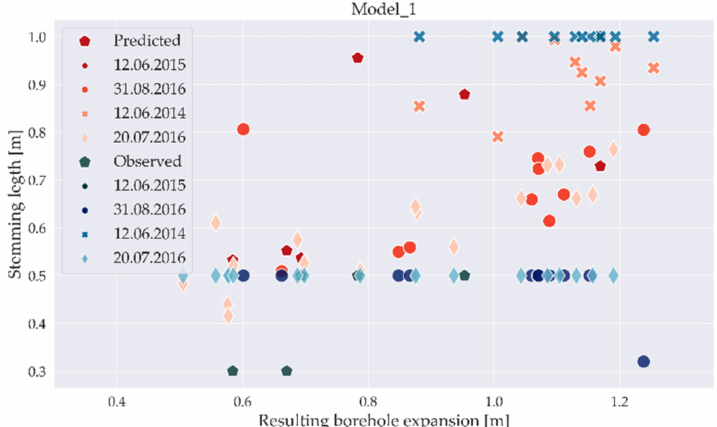
Figure 10. Model_1—Stemming length vs. resulting borehole expansion.